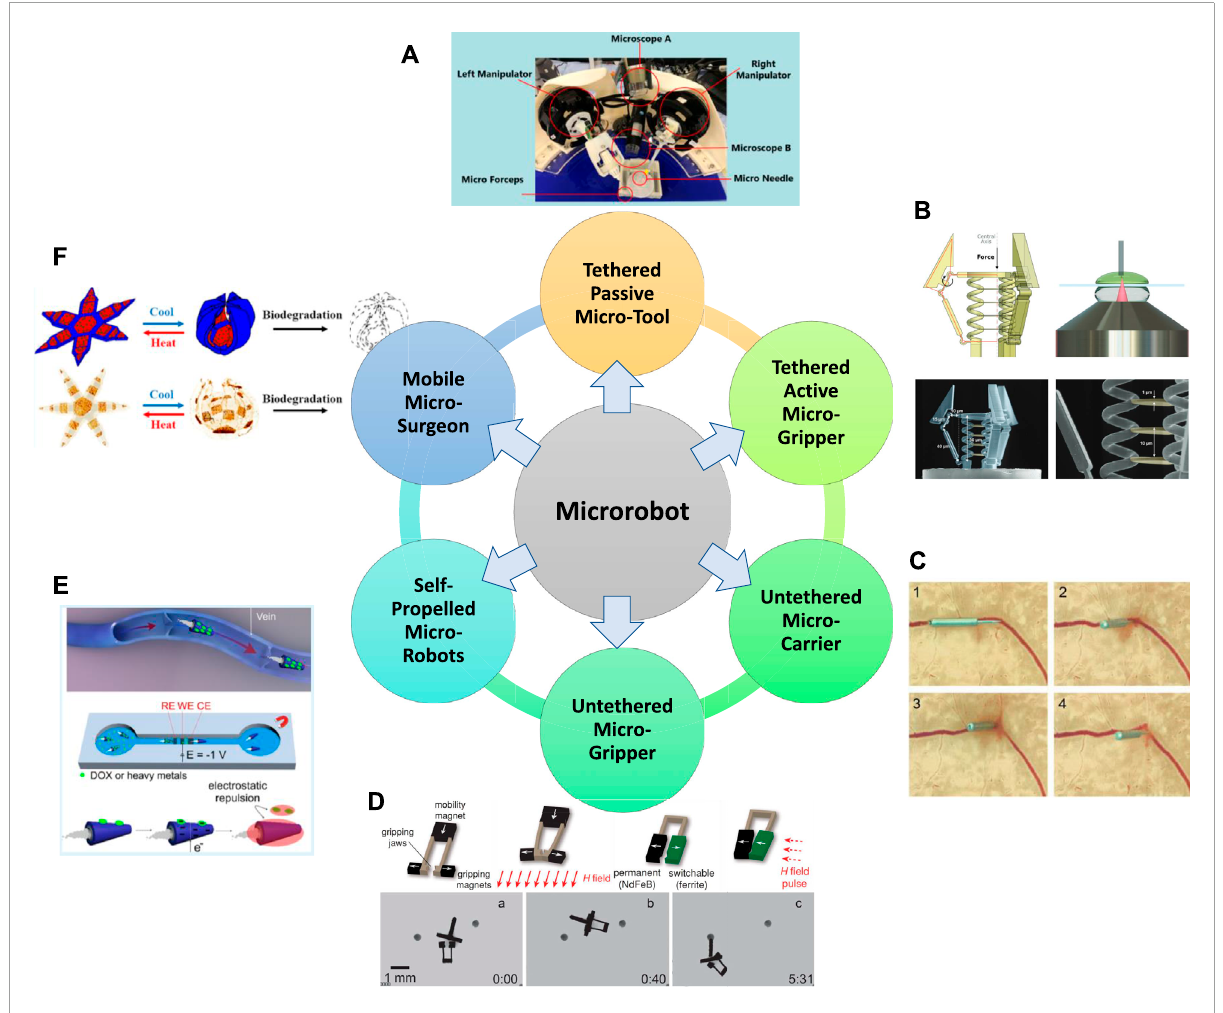
FIGURE 3 Overview of the six major categories of micro-robot built to date. (A) Tethered passive micro-tools (Zhang et al., 2020b; Zhang et al., 2020c), (B) Tethered active micro-grippers (Power et al., 2018), (C) Untethered micro-carriers (Chatzipirpiridis et al., 2015a), (D) Untethered micro-grippers (Diller and Sitti, 2014), (E) Self-propelled micro-robots (Beladi-Mousavi et al., 2019), (F) Mobile micro-surgeons (Kobayashi et al., 2018). Panel (A) reproduced from (Zhang et al., 2020b) under the terms of the CC-BY license. Copyright 2020, The Authors, published by Springer Nature. Panel (B) reproduced from (Power et al., 2018) under the terms of the CC-BY license. Copyright 2018, The Authors, published by Wiley. Panel (C) reproduced from (Chatzipirpiridis et al., 2015a) with permission. Copyright 2015, Wiley. Panel (D) reproduced from (Diller and Sitti, 2014) with